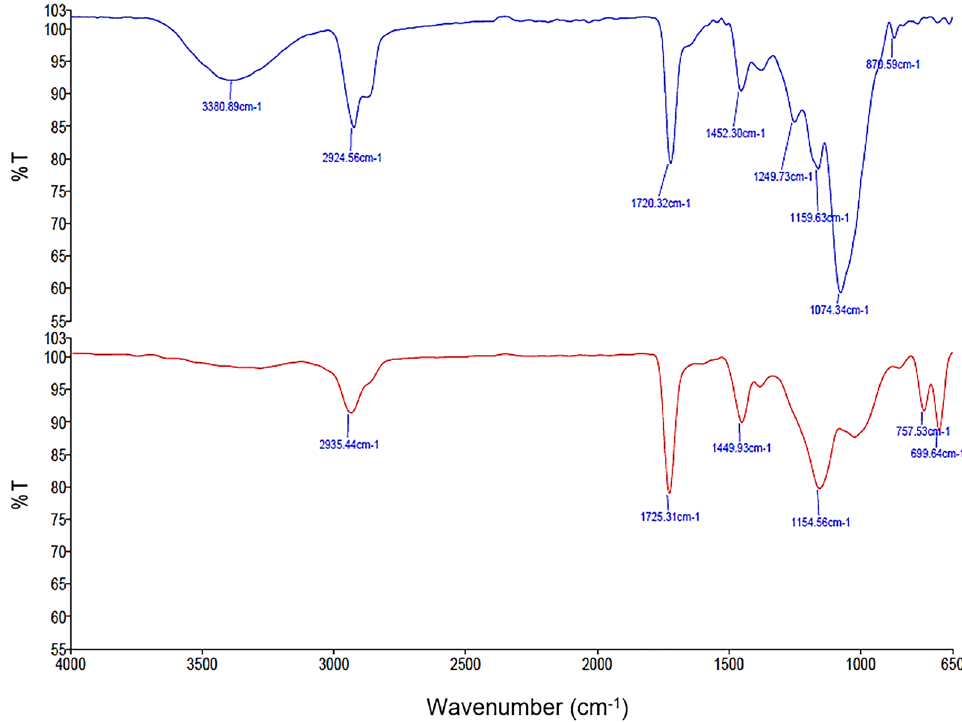
Figure 8. ATR-FTIR spectra comparison of the obverse area of genuine (blue spectrum) and counterfeit (red spectrum) RM50